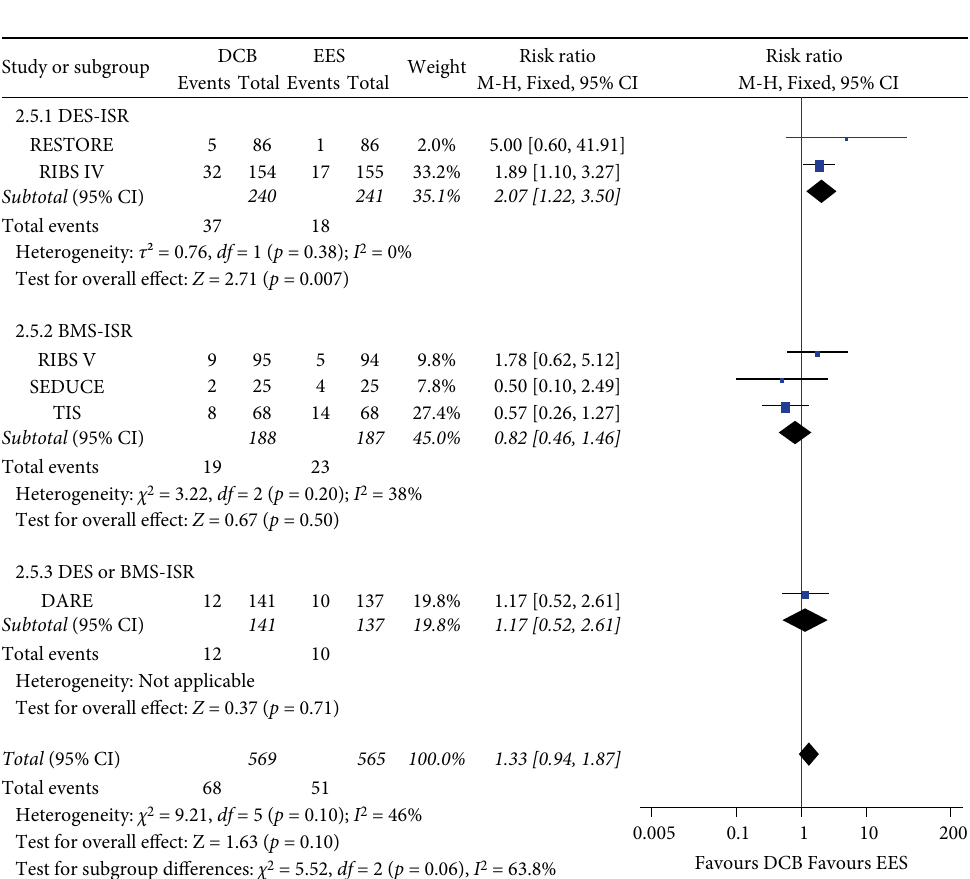
Figure 4: Summary of main event comparisons between DCB and EES across subgroups. BMS, bare-metal stents; DES, drug-eluting stents; DCB, drug-coated balloons; EES, everolimus-eluting stents.